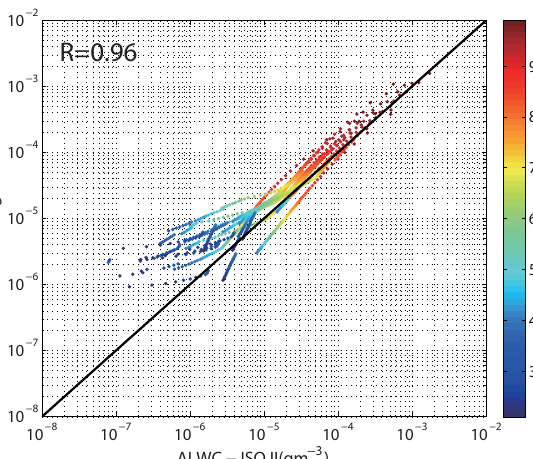
Figure 4. (a) Time series of the estimated ALWC during the HaChi summer campaign (denoted by the colour). (b) Diurnal variation of the estimated ALWC. (c) Daily averaged time series of the es- timated ALWC. The blue region of the time and diurnal series de- notes ± 1 standard